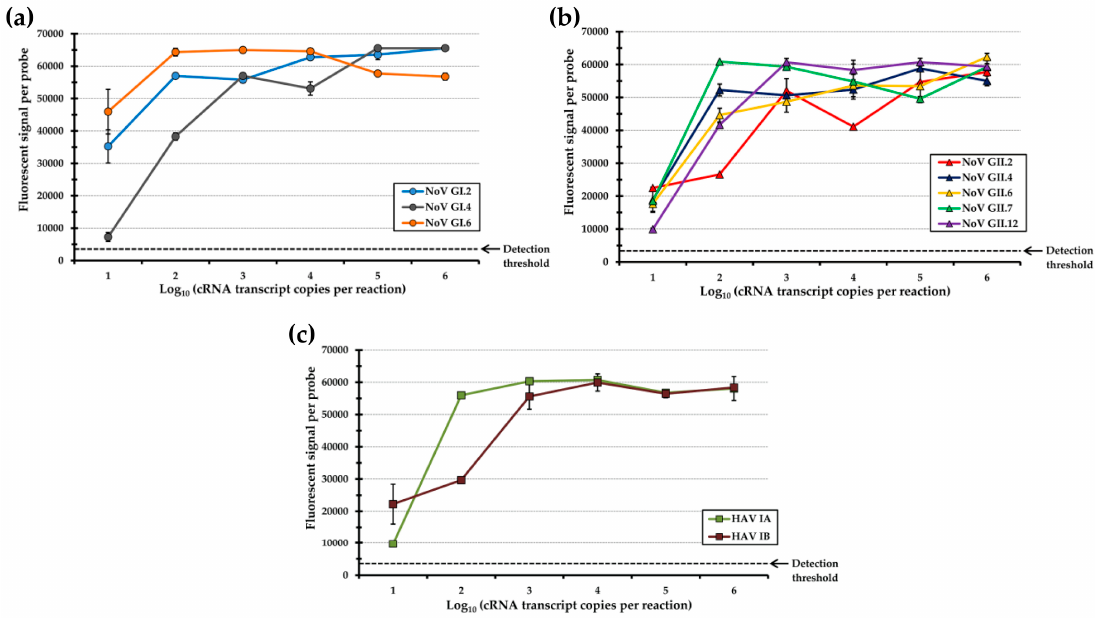
Figure 5. Hybridization signals of various amounts of in vitro cRNA transcripts from ( a ) NoV GI genotypes; ( b ) NoV GII genotypes; and ( c ) HAV genotypes were tested using the array-based typing method. The sensitivity detection threshold of the typing method is indicated by the dashed line.